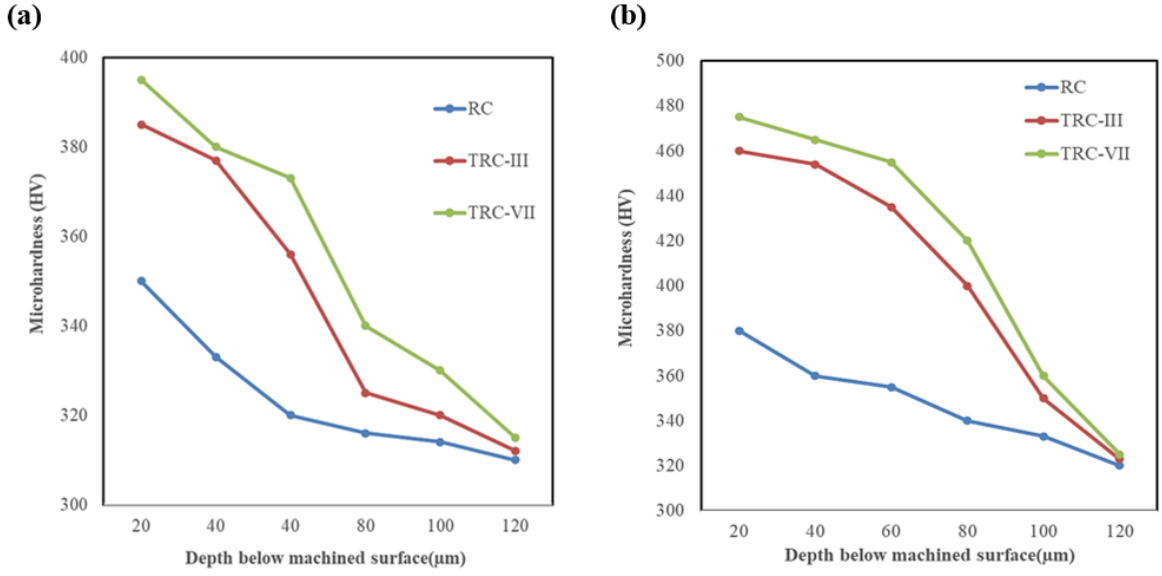
Figure 10. Distribution of micro-hardness underneath the machined surface, ( a ) Ti-6Al-4V and ( b ) Ti-6Al-7Nb.